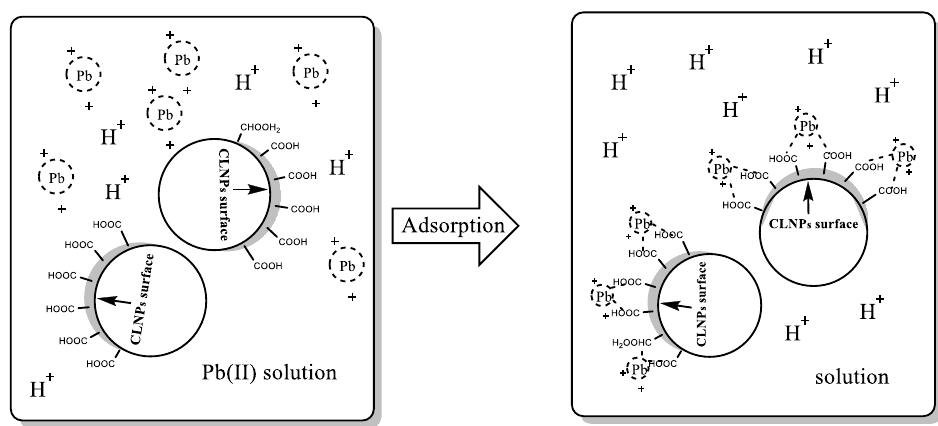
Figure 10. The typical XPS wide scan spectra of CLNPs before ( A ) and after ( B ) Pb(II) adsorption. O1s spectra of CLNPs before ( C ) and after ( D ) Pb(II) adsorption.